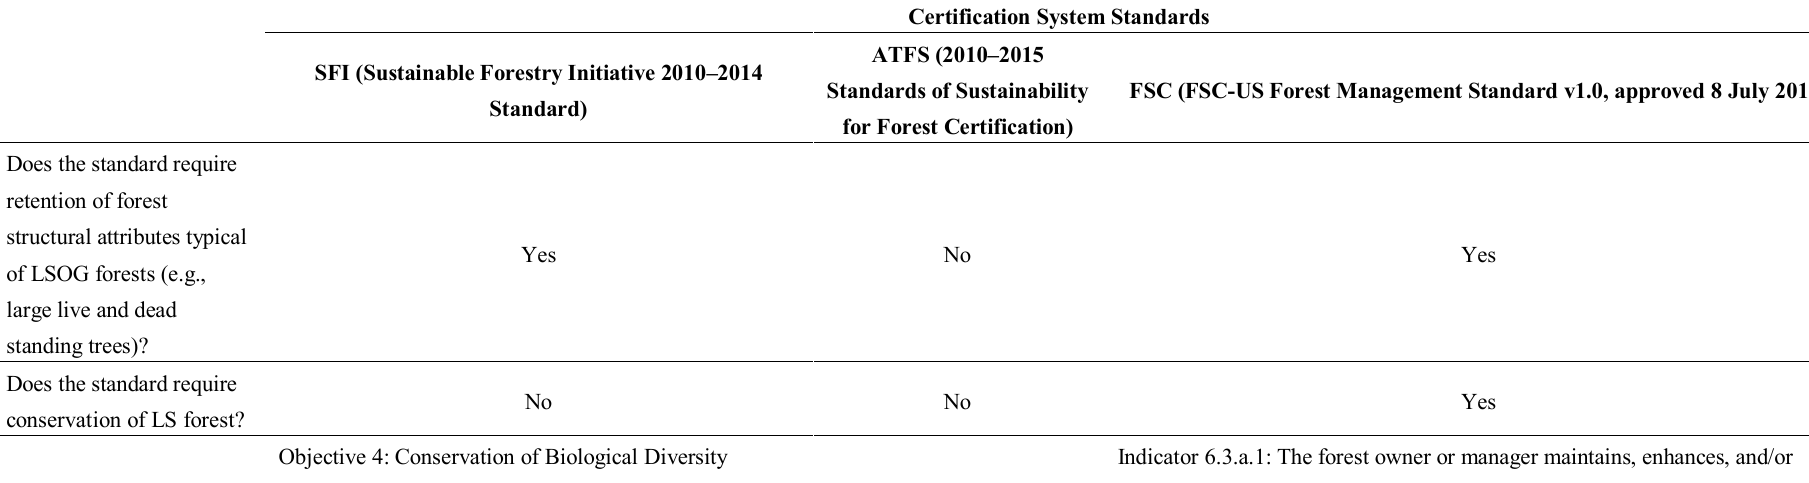
Table 5. Comparison of standards relevant to maintenance and enhancement of late-successional and old-growth (LSOG) forests in three forest certification systems: Sustainable Forestry Initiative [95], American Tree Farm System [96], and Forest Stewardship Council